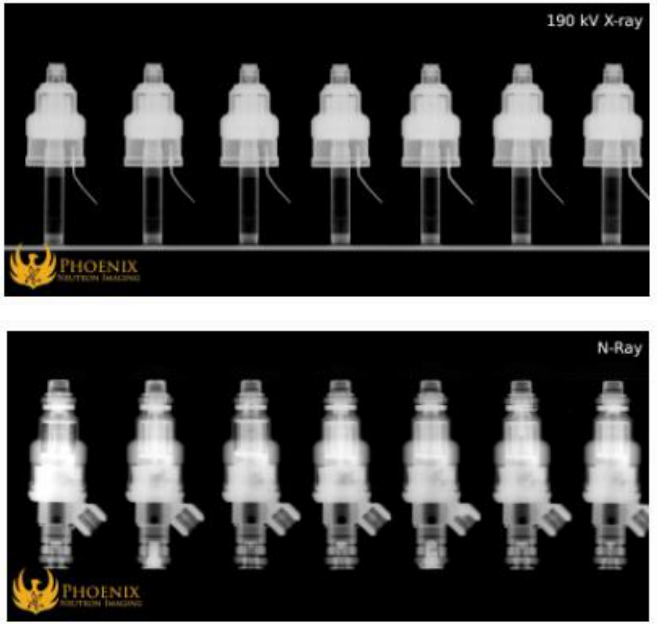
Figure 8. Comparison of imaging using X-rays ( top ) and neutrons ( bottom ). Used with permission.